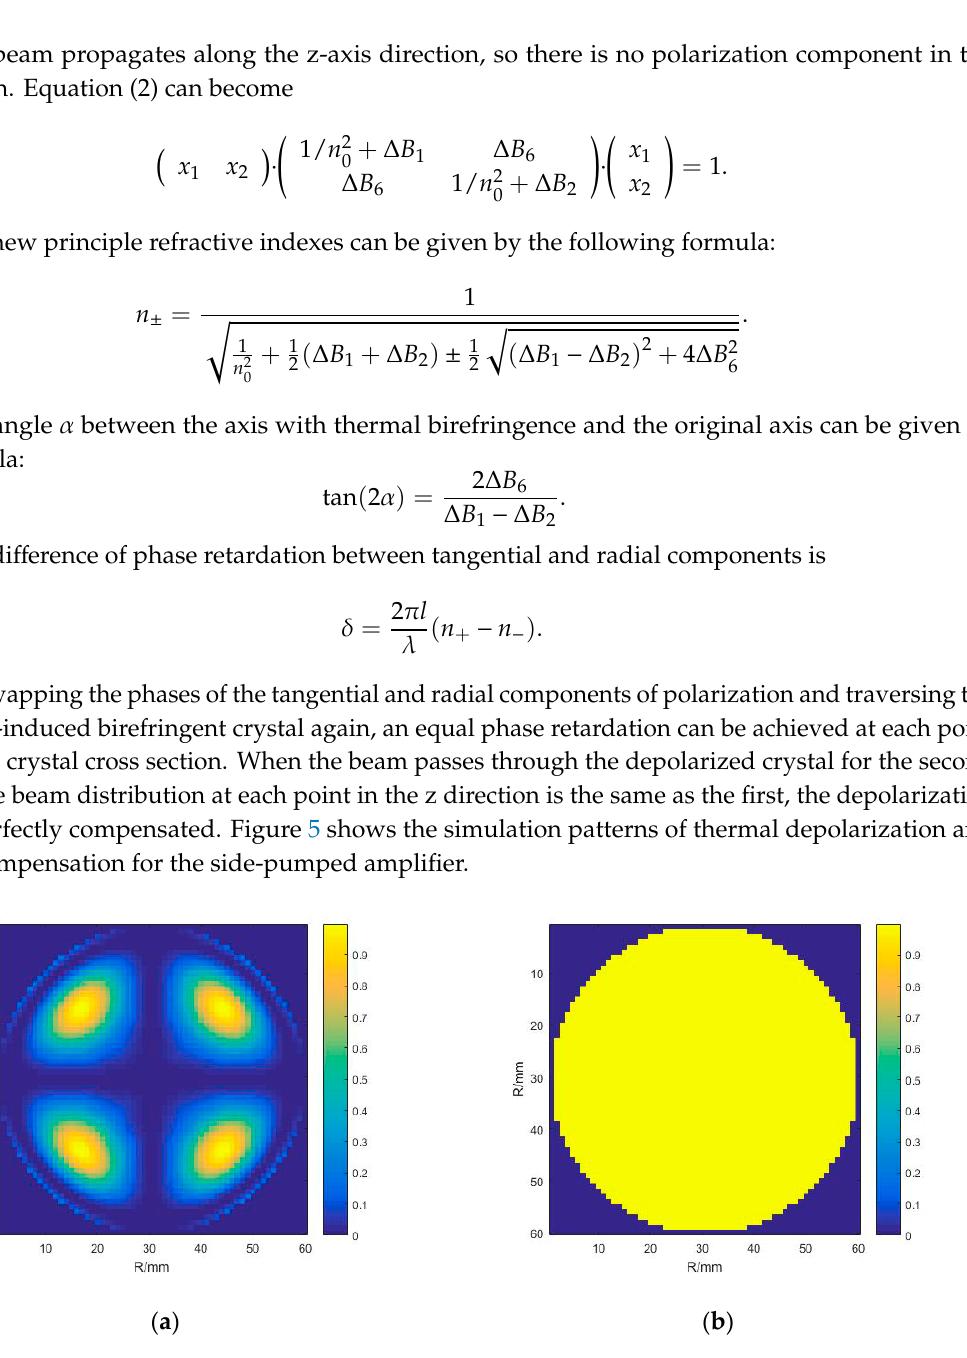
Figure 5. Simulation patterns of thermal depolarization and compensation ( a ) without compensation; ( b ) perfect compensation.